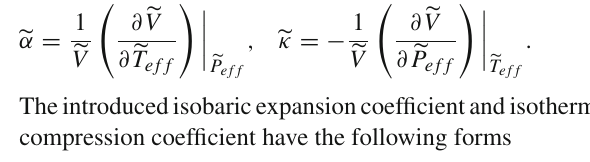
(red thick line), 1 100